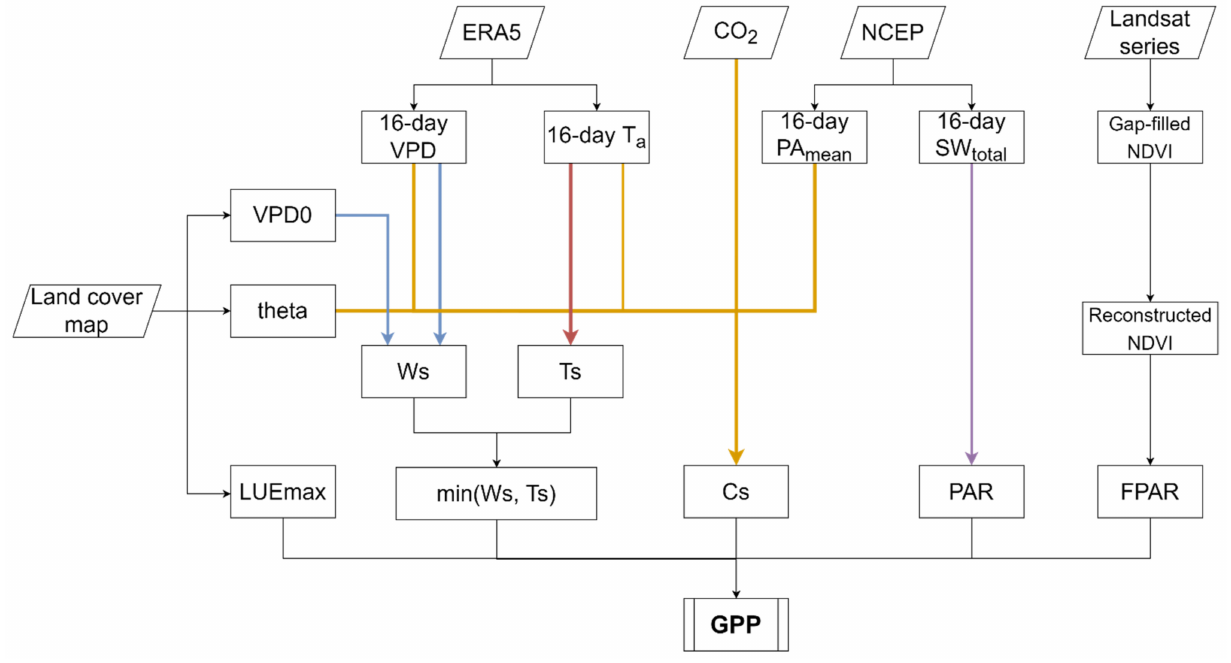
Figure 1. Workflow for generating fine-spatial-resolution GPP by the EC-LUE